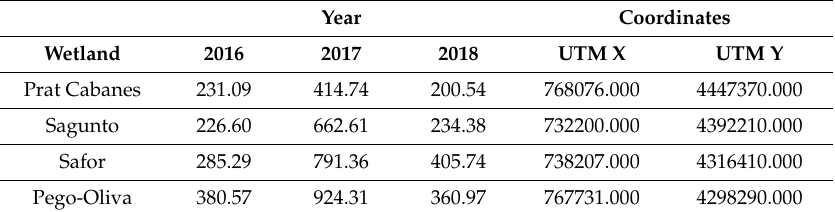
Table 1. Annual precipitation data (mm) and location of meteorological stations. Available in: http: // riegos.ivia.es / datos-meteorologicos.